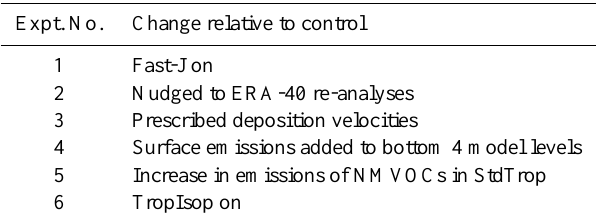
Table 12. Additional sensitivity experiments with the HadGEM2- UKCA coupled